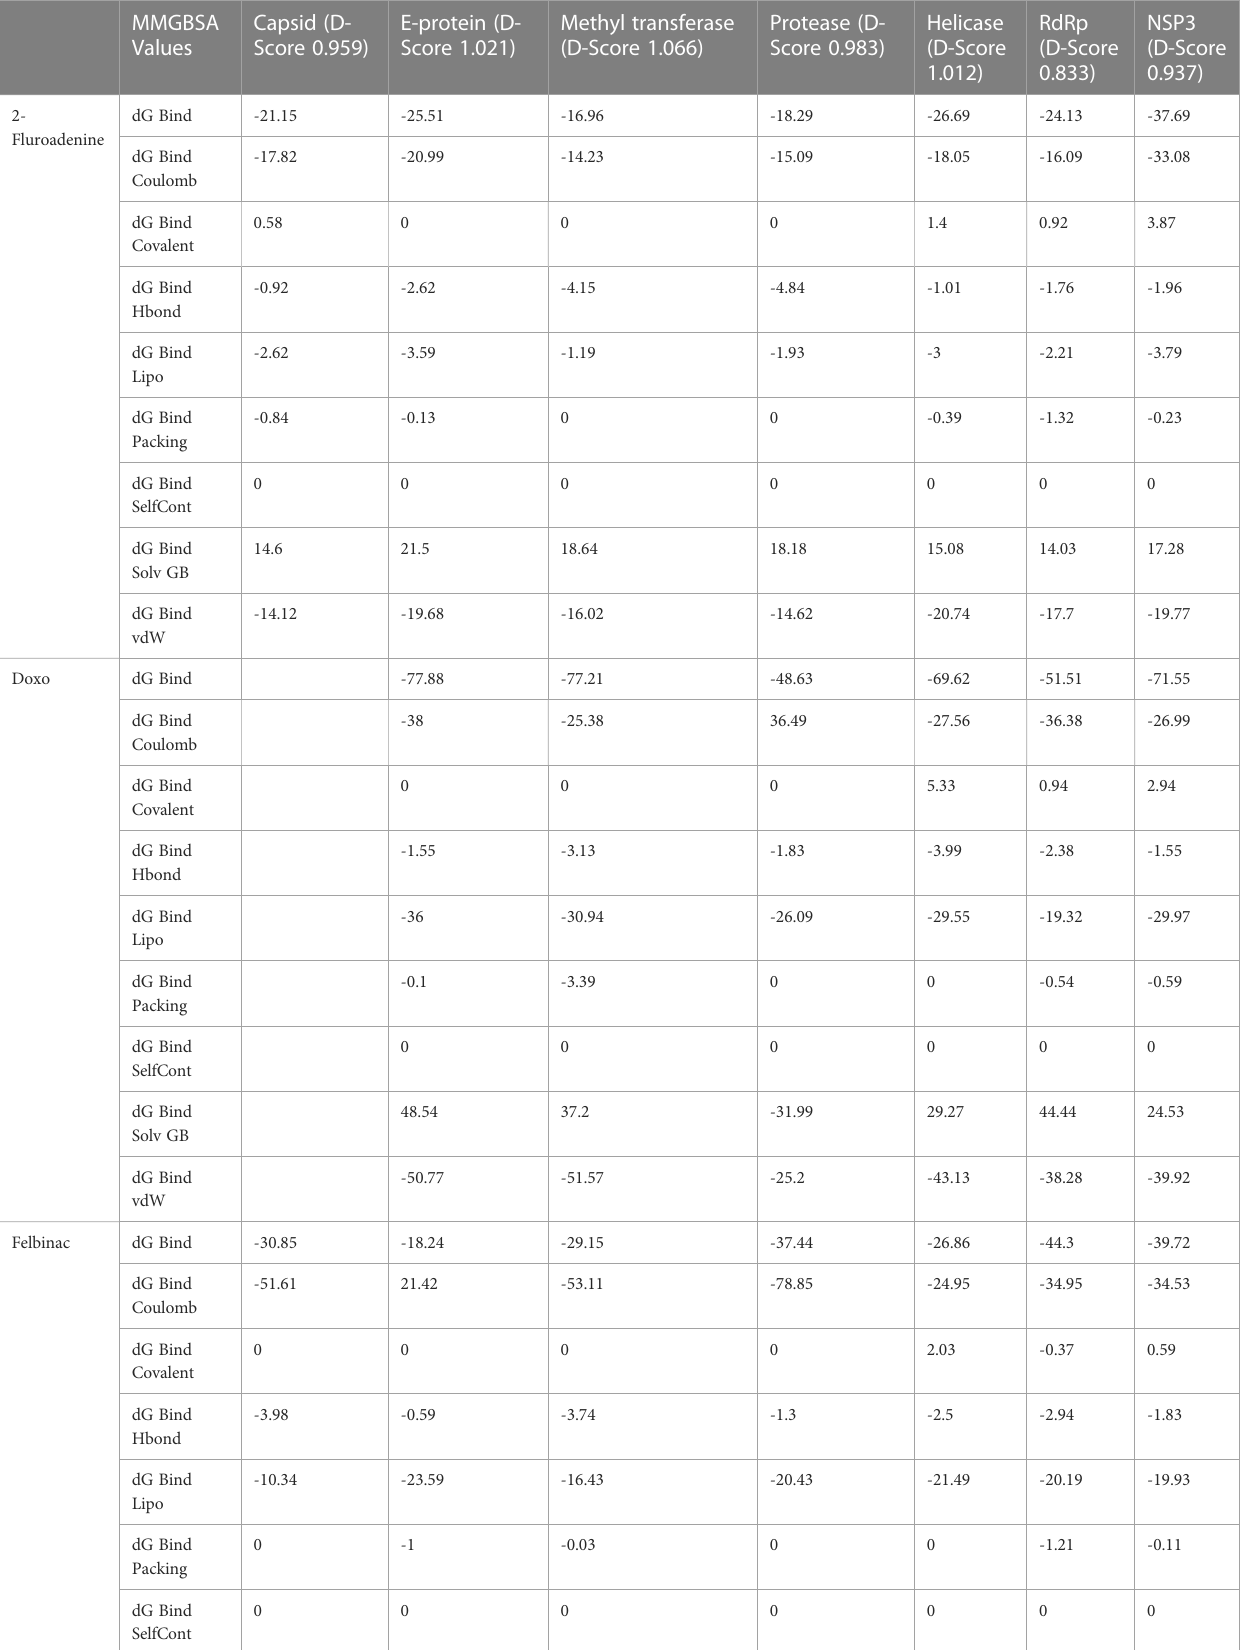
TABLE 5 Computational analysis of MM/GBSA binding free energies of compounds represented in